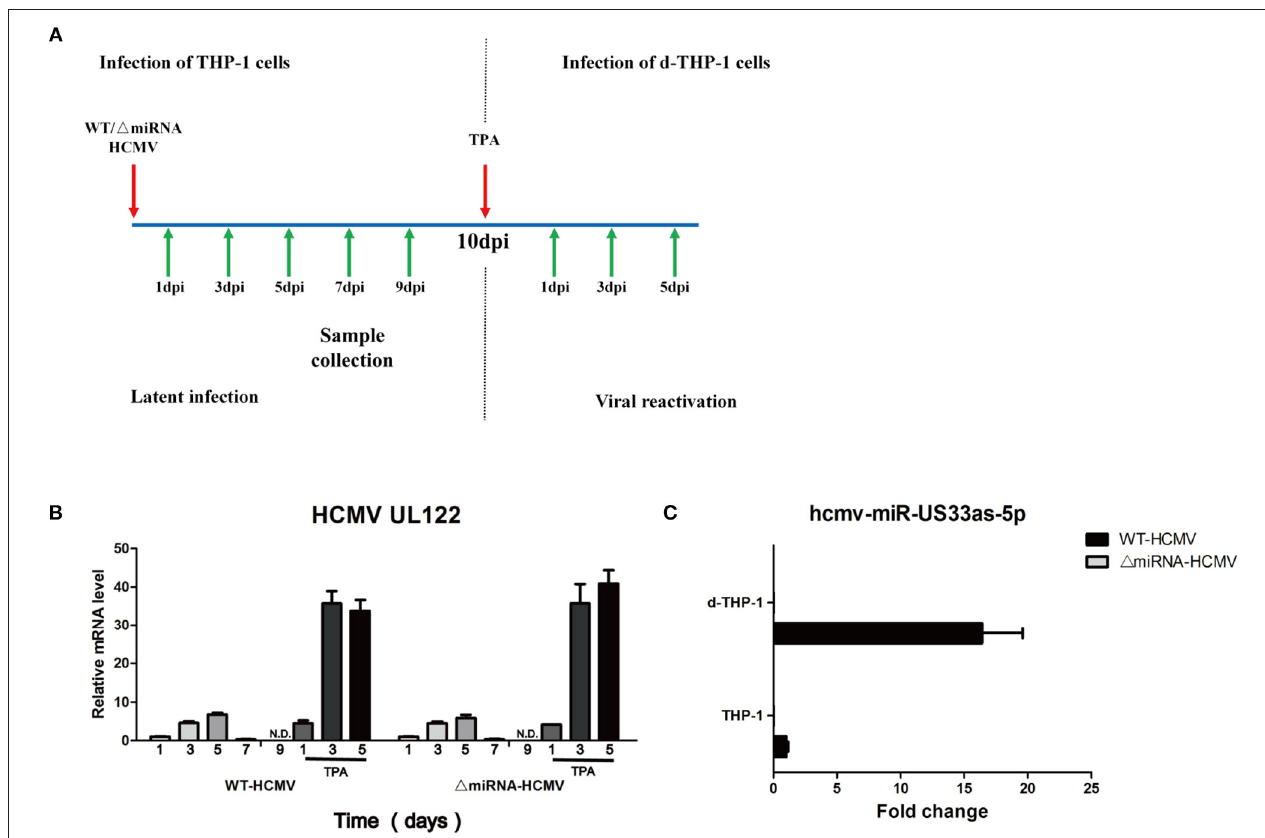
FIGURE 7 | hcmv-US33as-5p is expressed in both viral latency and reactivation. (A) A schematic diagram depicting in vitro models of latent infection and viral reactivation. THP-1 cells were infected with WT or 1 miRNA HCMV (MOI = 10) and maintained for 10 days in the culture medium. Then, the THP-1 cells were differentiated into macrophages (d-THP-1) by stimulated with TPA in order to render the cells permissive to HCMV infection and further maintained in the medium for another 5 days. (B) The expression of viral UL122 at 1, 3, 5, 7, and 9 dpi and 1, 3, and 5 days after TPA stimulation was detected by qPCR. (C) The expression of hcmv-US33as-5p at 9 dpi and 3 days after TPA stimulation was determined by